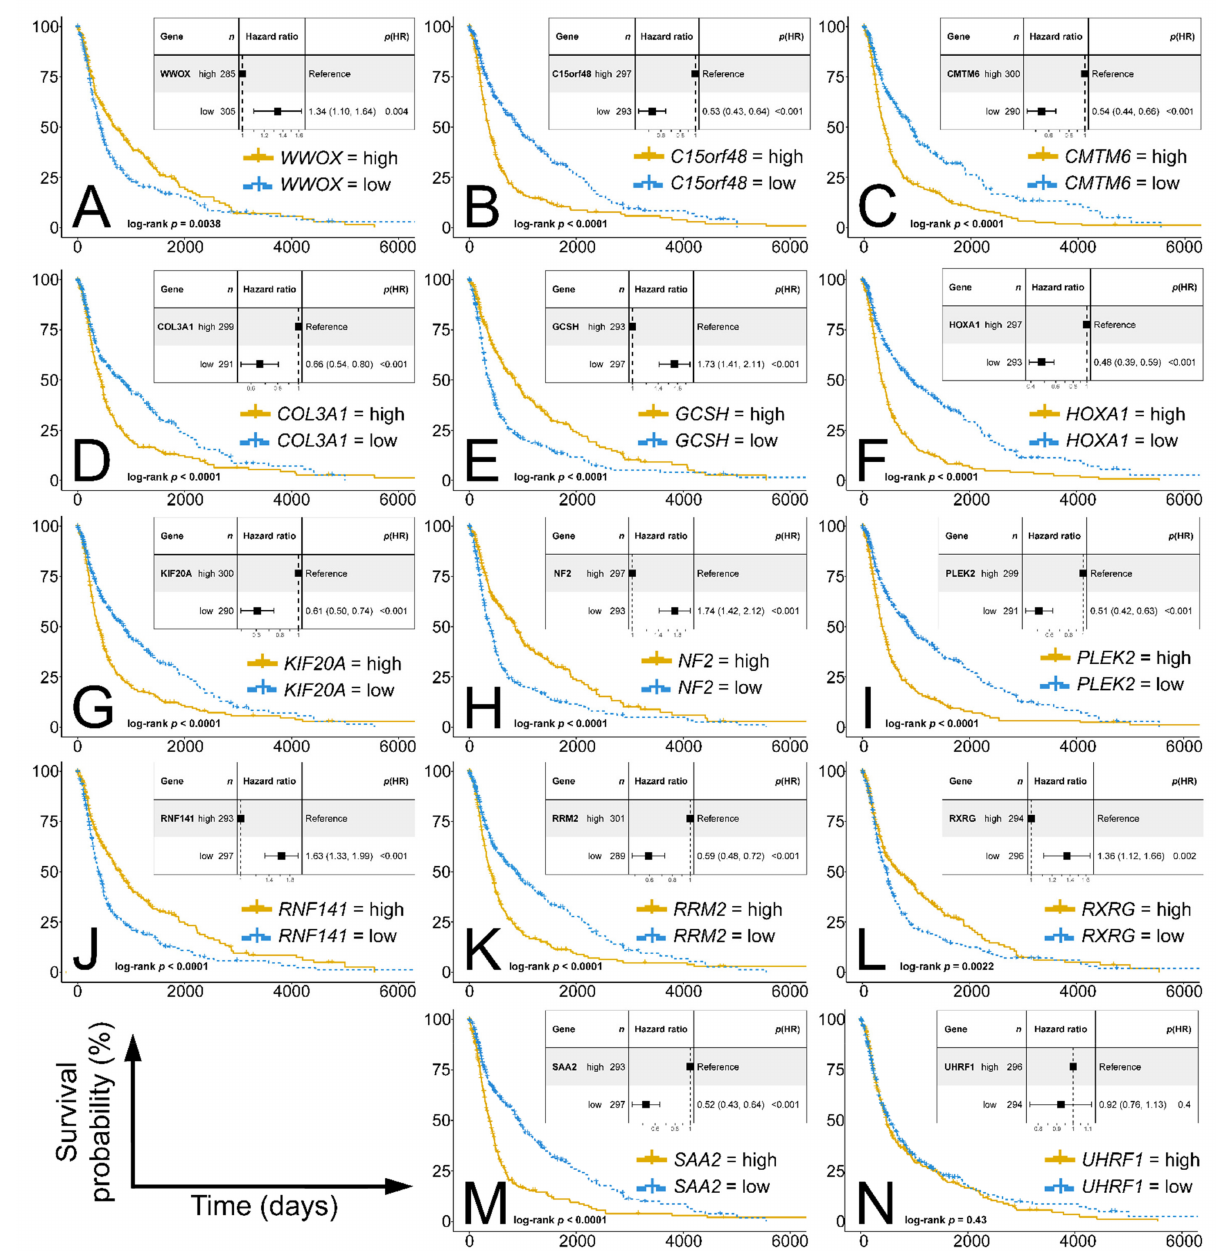
Figure 7. DFS analysis of the 13 most relevant genes and WWOX. ( A ) WWOX . ( B ) C15orf48 . ( C ) CMTM6 . ( D ) COL3A1 . ( E ) GCSH . ( F ) HOXA1 . ( G ) KIF20A . ( H ) NF2 . ( I ) PLEK2 . ( J ) RNF141 . ( K ) RRM2 . ( L ) RXRG . ( M ) SAA2 . ( N ) UHRF1 . 3.3. PLEK2, RRM2, and GCSH Were the Most Valuable in Differentiating Gliomas and Correlated with WWOX The remaining 12 genes were visualized in terms of their expression across all RNA-seq samples. The selection of three the most relevant genes was based on their predictive value (AUC), effect on survival (DFS), correlation with WWOX , and transparency of expression difference across UMAP dimensions. These were found to be PLEK2 , RRM2 , and GCSH . Together with WWOX , their expression difference across UMAP is visualized in Figure 8; the same for the remaining genes can be found in Figure